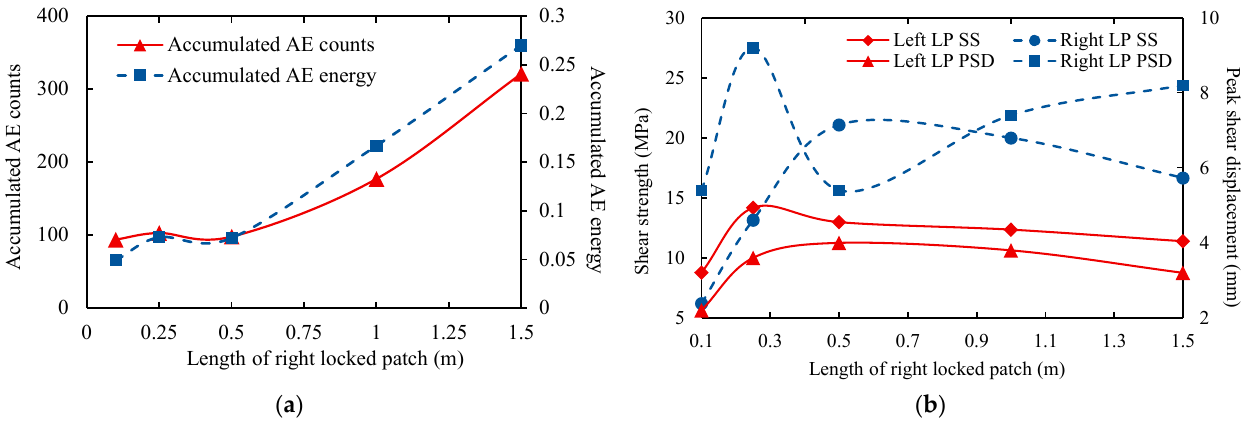
Figure 6. ( a ) Accumulated AE counts and energy variation with respect to length of right locked patch. ( b ) Shear strength and peak shear displacement variation with respect to length of right locked patch. LP denotes locked patch, and SS and PSD represent shear strength and peak shear displacement, respectively.